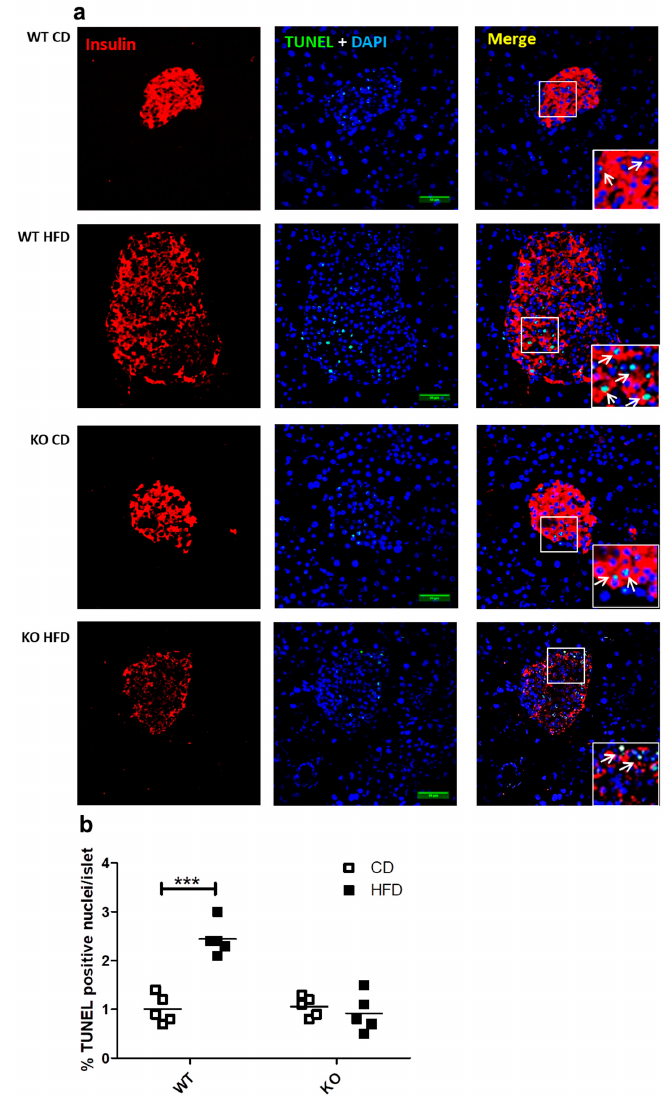
Figure 5. Study of apoptosis in situ in beta islets of WT and KO mice exposed to CD or HFD. Pancreas sections of 4 mm were stained with DAPI and immunostaining for insulin in order to identify the beta cells in islets, and apoptosis was determined by TUNEL (Terminal deoxynucleotidyl transferase dUTP nick end labeling) staining and analyzed by confocal microscopy. ( a ) White arrows indicate examples of TUNEL-positive nuclei within the islets. Scale bar represents 50 µ m. Percentage of apoptotic TUNEL + nuclei per islet is quantified in ( b ) The results are representative of at least three sections per animal, with a total of five animals for each WT and KO group. p values were calculated by two-way ANOVA with a Bonferroni post-test, with *** p < 0.001. Data are shown as individual data points with their respective